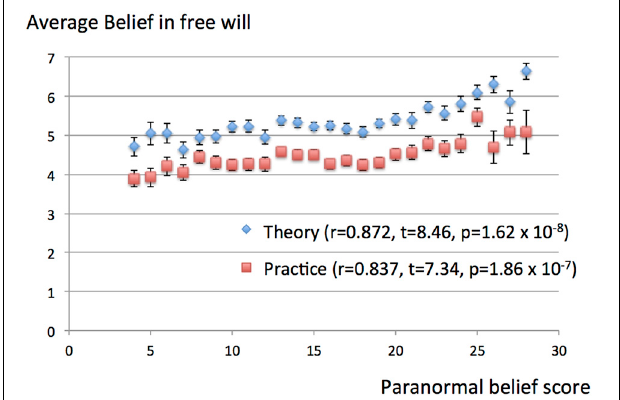
FIGURE 1 | Average belief in free will for particular paranormal belief scores. The scores for belief in free will (theory and practice) are average and plotted for subjects with particular paranormal belief scores. The possible range of scores for belief in free will was 1–7, while that for paranormal belief was 4–28. Vertical bars represent standard errors of the mean. The correlation coefficients between the paranormal belief score and beliefs in free will (theory and practice) were 0.872 ( t = 8 . 46, p = 1 . 62 × 10 − 8 ) and 0.837 ( t = 7 . 34, p = 1 . 86 × 10 − 7 ), respectively.